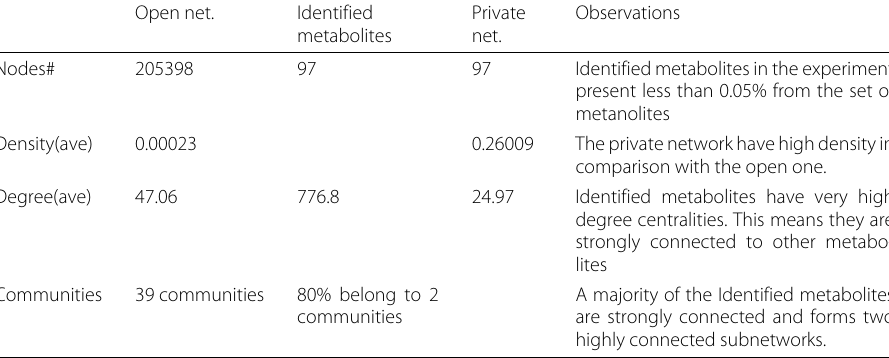
Table 7 Metabolites layer analysis: summary of results for the minimum combing score Open net.